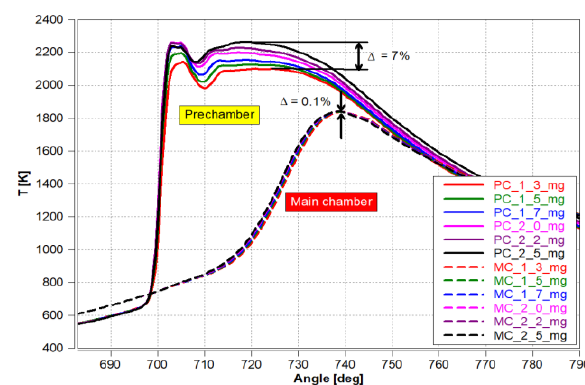
Fig. 11. Combustion temperature changes in the prechamber and in the main chamber Division of the computational grid into selections al- lowed an independent determination of the average temper- ature values in the main chamber. The temperature changes in this part of the cylinder were practically the same (changes in T were about 0.1%). Maximum values ob- mx served in the main chamber were about 350–400 K smaller than in the prechamber. Temperature increase in the main chamber was shifted by about 20 deg CA in relation to the temperature increase in the prechamber.